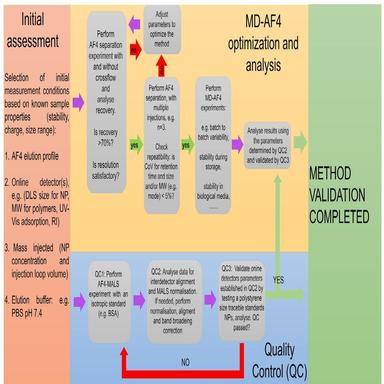
Brief outline of the workflow of MD-AF4 measurements. Fours step are represented: 1) assessment of sample properties that helps determining the initial testing conditions (orange box); 2) MD-AF4 method optimization and testing according to ISO/TS 21362 (yellow box); 3) quality control to be run in parallel to MD-AF4 method optimization (blue box); 4) method validation completed (green box). Violet arrows represent data input, red arrows negative results, while green arrows successful experiments with result